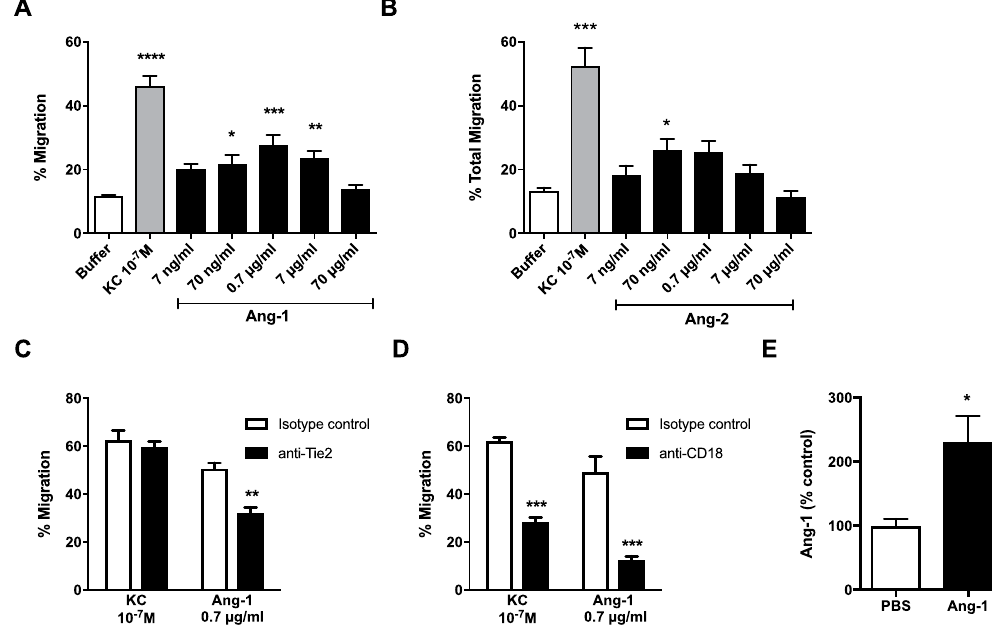
Figure 2. Chemotactic response of mouse neutrophils to rhAng-1 ( A ) and rhAng-2 ( B ). Dose-response effects of rhAng-1 and rhAng-2 on isolated mouse peripheral blood neutrophil chemotaxis. KC (10 − 7 M) was used as a positive control. Results presented as mean ± SEM (n = 4) and analysed for statistical significance using ANOVA followed by Dunnett’s comparing all to buffer control. * P < 0.05 ** P < 0.01 *** P < 0.001. The effect of isotype control (rat IgG1), anti-Tie2 (12 µ g/ml; 6 µ g/10 − 6 cells) ( C ) or anti-CD18 (GAME-46) ( D ) (15 µ g/ml; 7.5 µ g/10 − 6 cells) on chemotaxis induced by KC (10 − 7 M) or rhAng-1 (0.7 µ g/ml). Results presented as mean ± SEM (n =